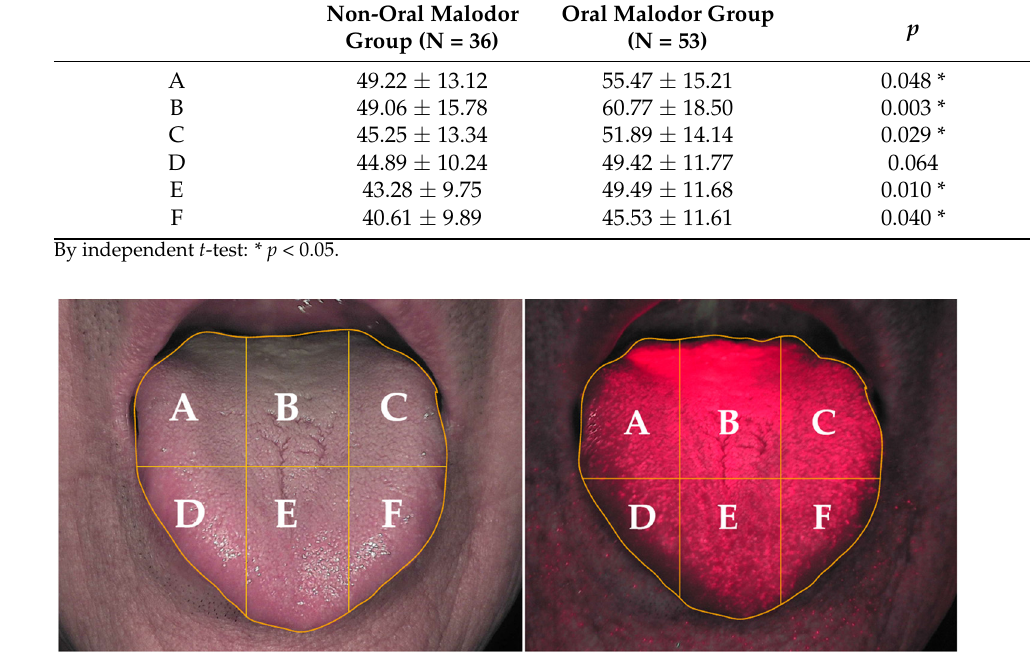
Figure 4. Tongue-coating distribution by tongue area following analysis.